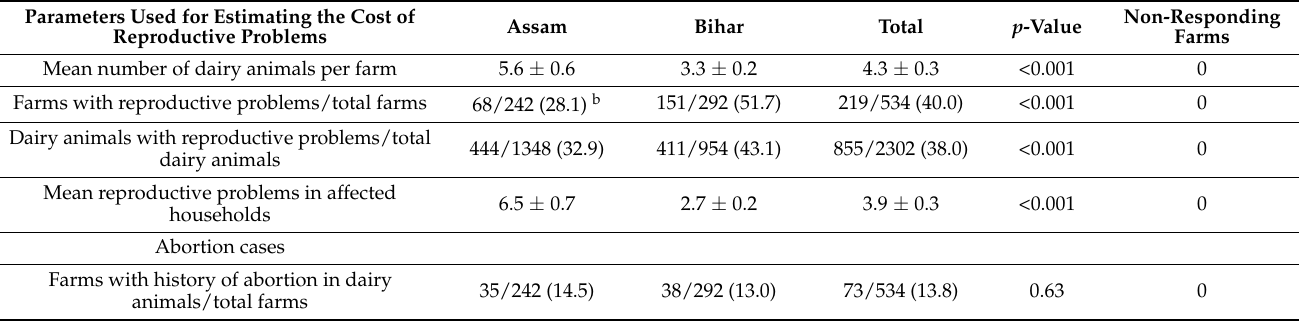
Table 2. Parameters used for estimating the cost of selected reproductive problems a with reported positive observa- tions/total observations (percentage) or mean value of the positive observations in the surveyed dairy farms of Assam and Bihar, p -value of inter-state variation and absent data (non-responding